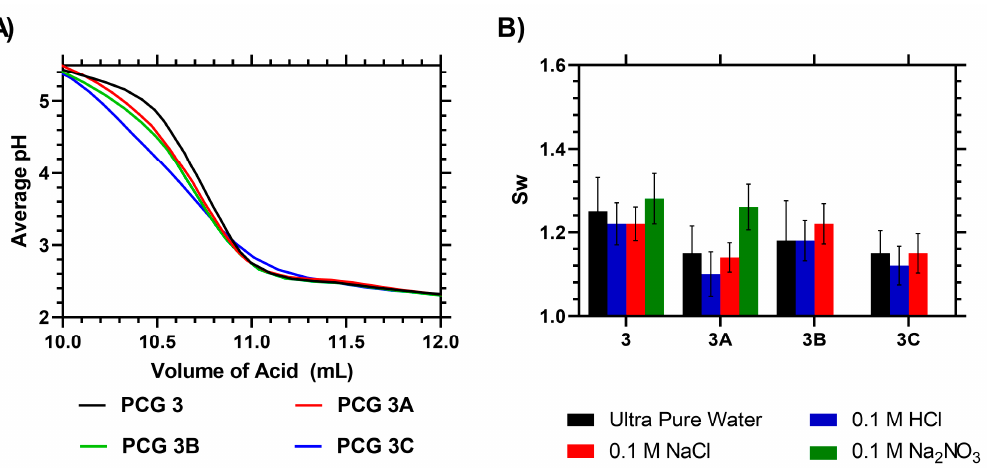
Figure 4. ( A ): Raw titration data of AA-copolymerized RAFT–HEMA films. ( B ) S w of AA- copolymerized RAFT–HEMA films at different pH levels.